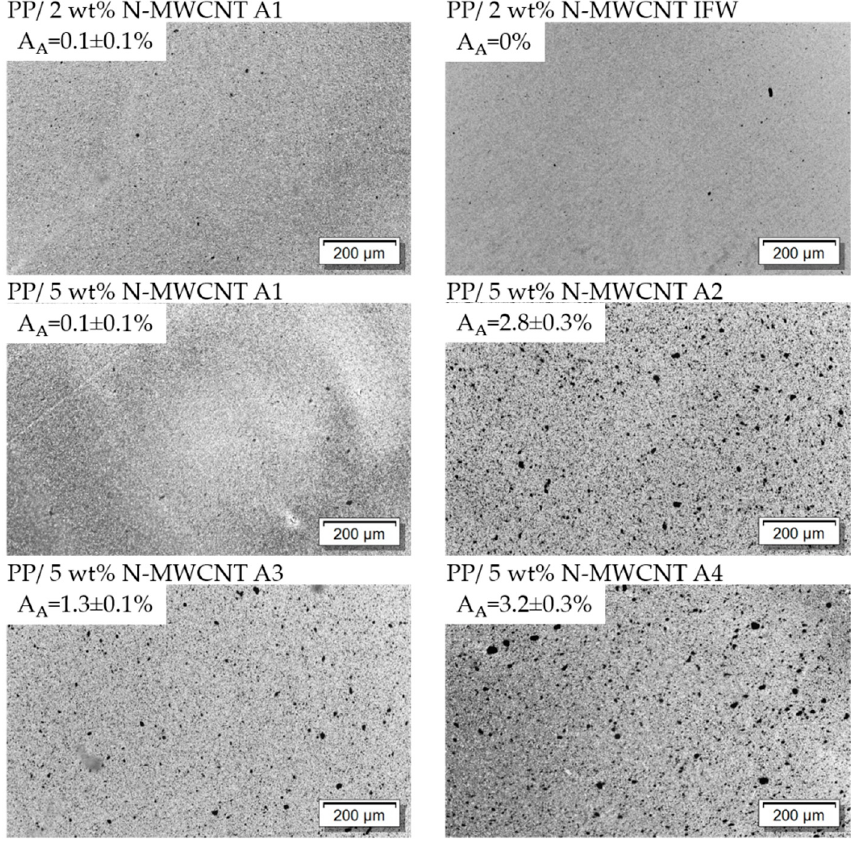
Figure 5. Transmission light microscopy images of thin sections of PP composites with N-MWCNTs, the insert shows the agglomerate area ratio A